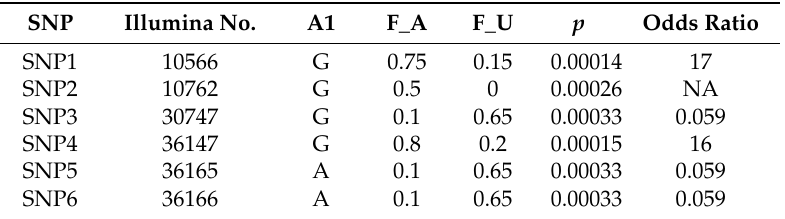
Table 1. Candidate SNPs identified from the exploratory GWAS. A1 indicates the minor allele (i.e., least frequently observed based on the whole sample); F_A and F_U indicate the frequency of the minor allele in the a ff ected and una ff ected cats, respectively. The p value is shown calculated by Fisher’s Exact test and Bonferroni corrected by PLINK. No odds ratio could be calculated for SNP2 because the associated allele was not found in una ff ected cats. SNPs were named in the Illumina array only as custom numbers; for convenience, they are named here as SNPs 1 to